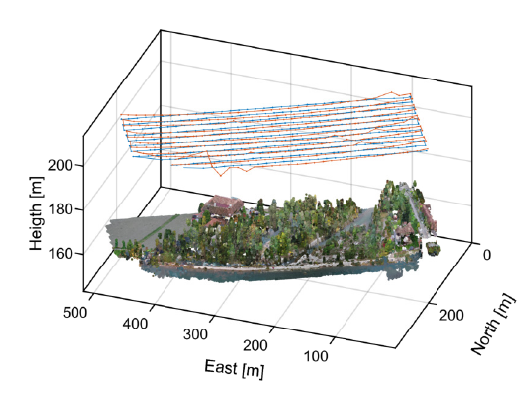
Figure 3. Telemetry trajectory (blue) and photogrammetric-relative trajectory (red). The latter was converted in the absolute reference system by means of the approximated Helmert transformation. The vertical axis is 4 times scaled with respect to the horizontal ones.